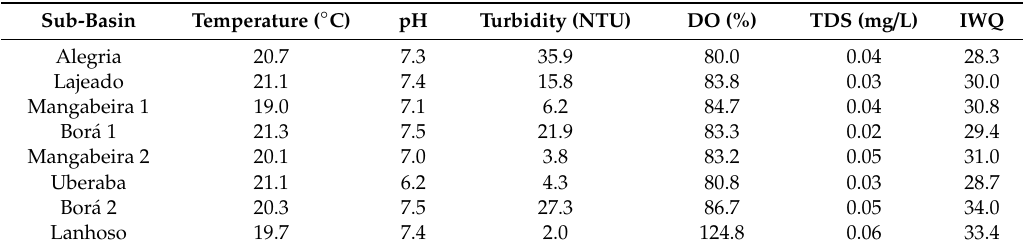
Table 3. Average water quality based on the five parameters used to calculate the IWQ (Index for Water Quality) index (Equation (1)). The full inventory of values, obtained within the monitoring